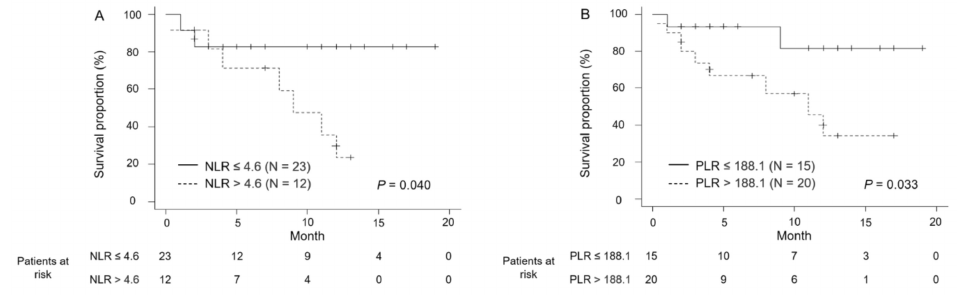
Figure 2. Kaplan–Meier estimates of progression-free survival (PFS) according to neutrophil-to- lymphocyte ratio (NLR) stratified by a cut-off value of 4.6 ( A ) and to platelet-to-lymphocyte ratio (PLR) stratified by a cut-off value of 188.1 ( B ). According to NLR stratification, the 1-year PFS rates were 82.6% when NLR ≤ 4.6 and 23.7% when NLR > 4.6 ( p = 0.04; Figure 2A). Based on PLR stratification, the 1-year PFS rates were 81.7% when PLR ≤ 188.1 and 34.3% when PLR > 188.1 ( p = 0.033; Figure